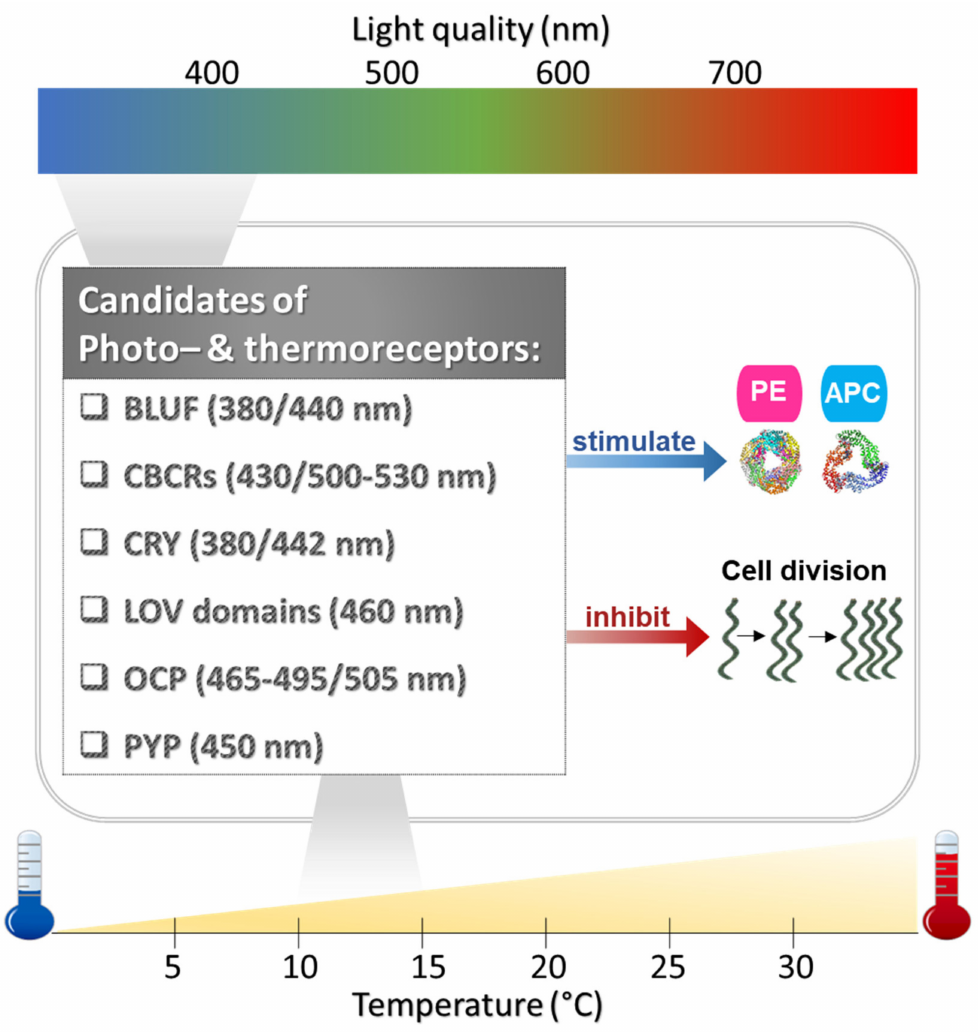
Figure 5. A conceptual framework for the possible simultaneous perception of blue light and low temperature by dual receptors in A. maxima that signal the production of phycoerythrin (PE) and allophycocyanin (APC) [83] and delay cell proliferation. BLUF: sensor of blue light using flavin adenine dinucleotide (FAD) [84], CBCRs: cyanobacteriochrome [85], CRY: cryptochrome [86], LOV PYP: photoactive yellow protein